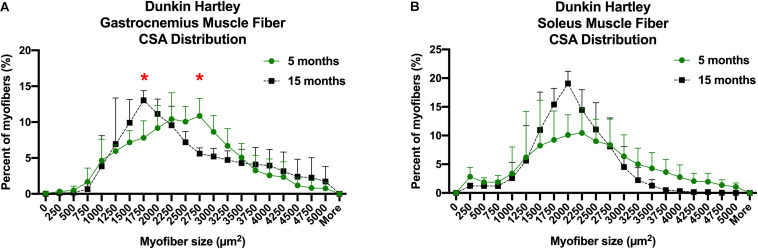
CSA distribution of all myofibers in both the gastrocnemius and soleus of Dunkin-Hartley guinea pigs. 15 mo guinea pigs had a greater proportion of 1750 μm2 myofibers and less 2750 μm2 myofibers compared to 5 mo guinea pigs (p < 0.05; A). However, there was no difference in myofiber size distribution in the soleus (B). *denotes p < 0.05 compared to 5 mo.